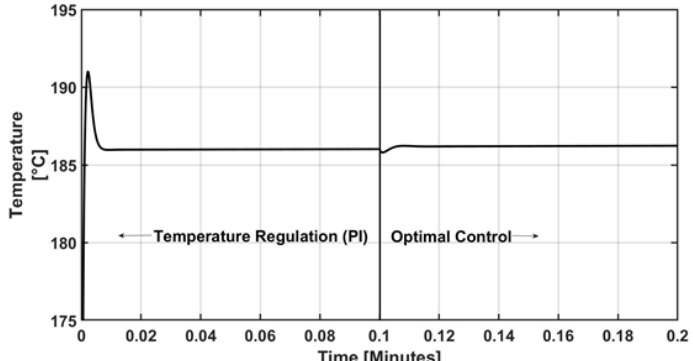
Figure 2. Closed-loop dynamic behavior of the reactor temperature.